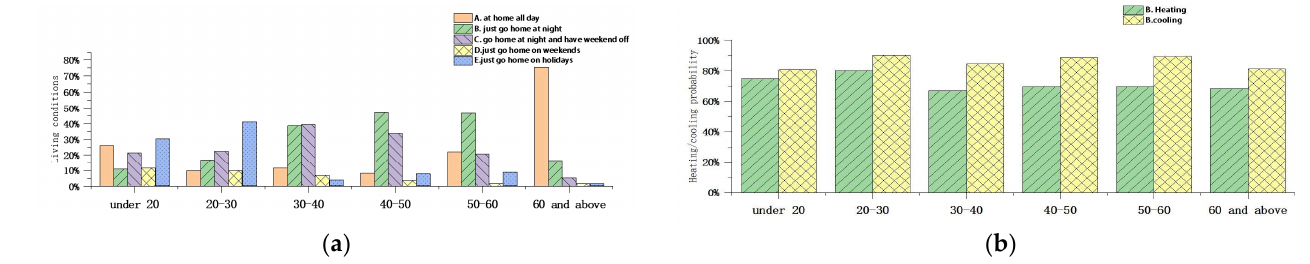
Figure 3. ( a ) Probability of differently aged people’s activities in winter; ( b ) probability of heating by people of different ages in summer and winter. * Under 20 years old: n = 154; 20.30 years: n = 221; 30.40 years: n = 102; 40.50 years: n = 387; 50.60 years: n = 131; over 60 years old: n = 135 ( n refers to the number of people within this age bracket who answered this questionnaire).